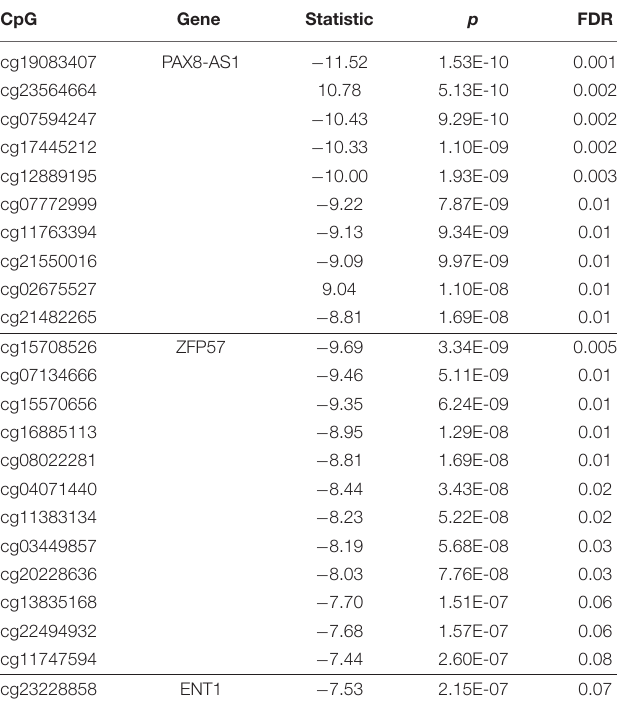
TABLE 4 | cis -eQTM sites ( < 1 Mbp from a gene) with false discovery rate (FDR) < 0.05 are shown, with the exception of three sites corresponding to ZFP57 and an additional gene of interest ( ENT1 ).